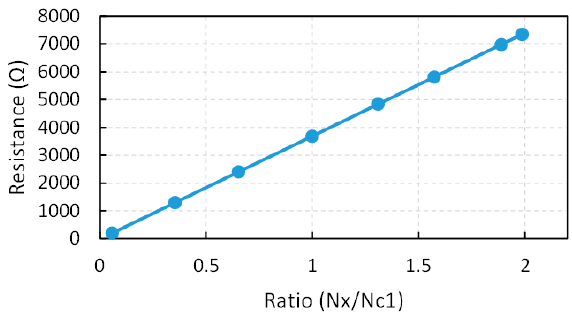
Figure 11. Experimental transfer characteristic with linear interpolation used to obtain Equation (9).